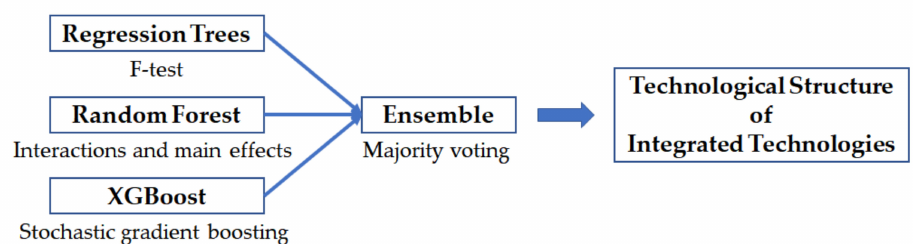
Figure 12. Technological structure of integrated technologies of disaster AI and